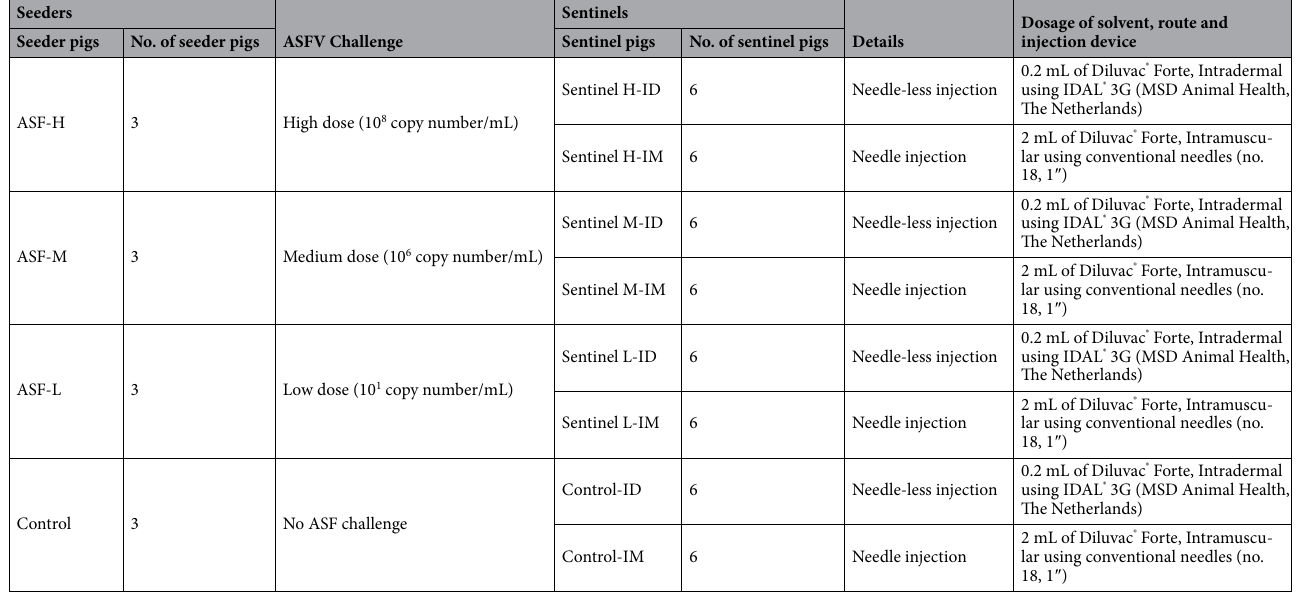
Table 1. Experimental design of the ASFV transmission